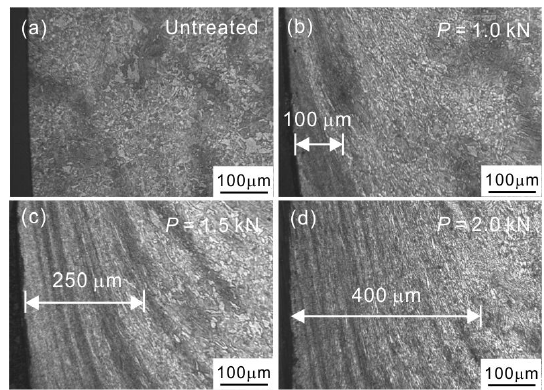
Figure 1. Cross-sectional metallographic observations of ( a ) the untreated specimen and ultrasonic surface rolling processing (USRP) specimens treated at a static load of ( b ) 1.0 kN, ( c ) 1.5 kN and ( d ) 2.0 kN. The distance between the white lines represents the thickness of the deformation layer near the surface of the USRP specimens.